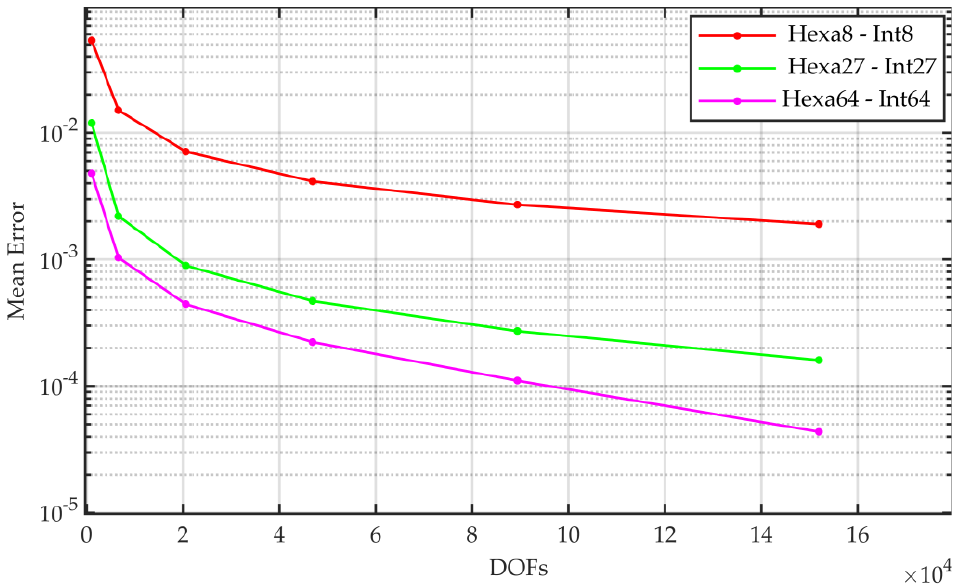
Figure 2. Convergence analysis of the full − order FE formulations as a function of the number of DOFs.